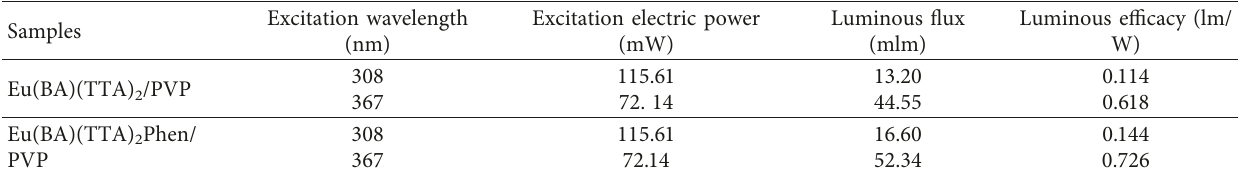
Eu(BA)(TTA) 2 Phen/ PVP